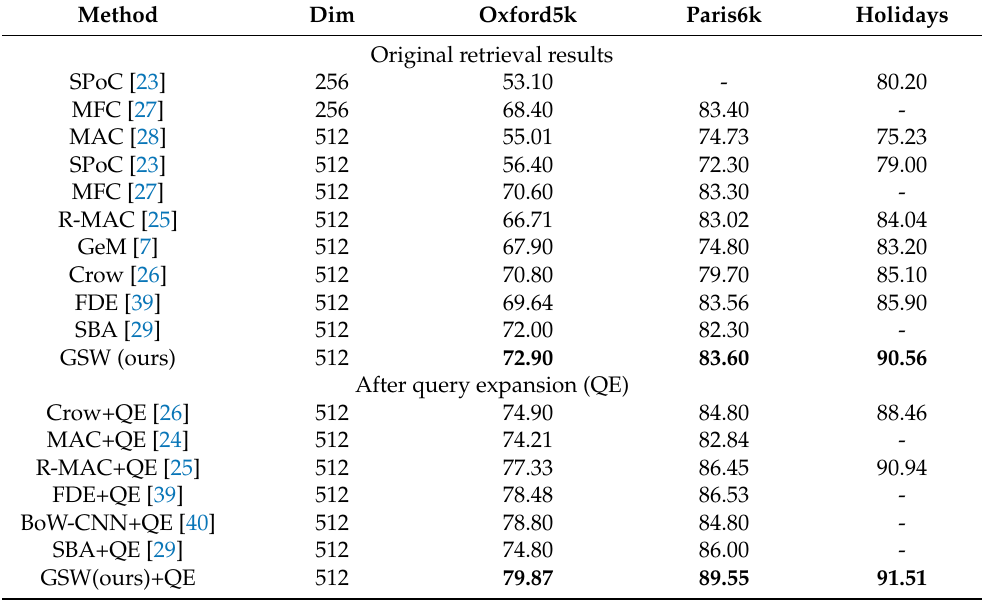
Table 6. Performance (mAP) comparison with the state-of-the-art algorithms in Oxford5k, Paris6k and Holidays. Dim: dimensionality of final compact image feature descriptors. QE: using query expansion (+QE). The best result is highlighted in bold. SPoC, simplest sum-pooled convolutional; MFC, multiscale fully convolutional; MAC, maximum activation of convolutions; GeM, generalized- mean pooling; FDE, fusing feature distribution entropy; SBA, semantic-based aggregation; BoW, bag-of-visual